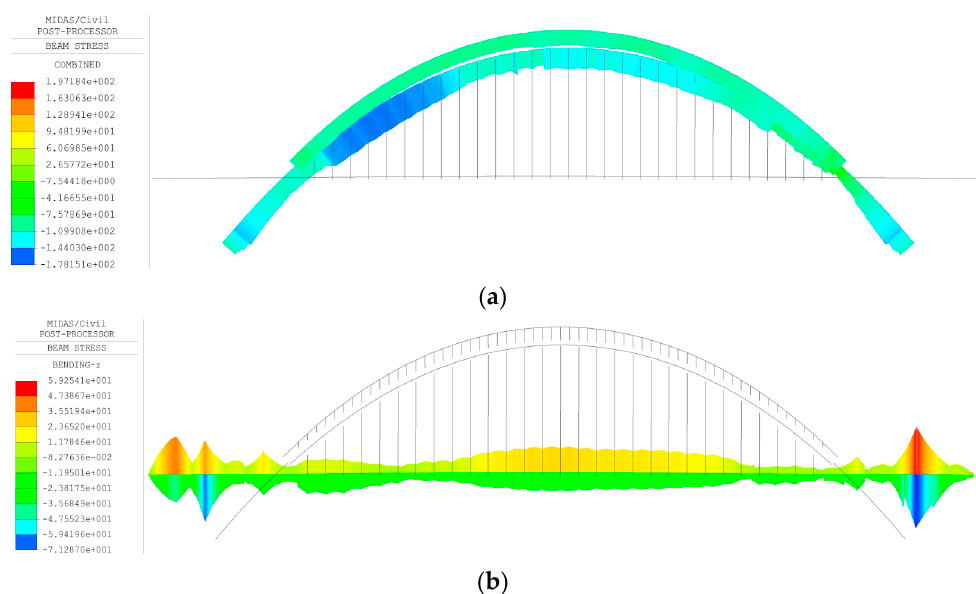
Figure 9. Load-bearing capacity limit state load combination stress (unit: MPa): ( a ) arch ribs; ( b ) main girder. Table 6. Cable force of suspenders in service stage.